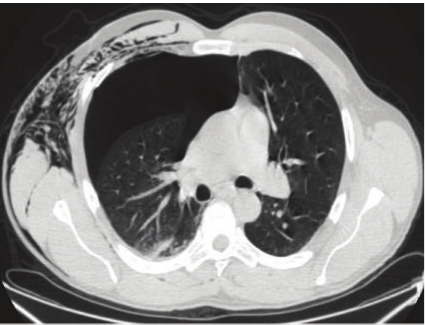
Figure 11: Tension pneumothorax. Axial MDCT in lung window at the level of the pulmonary trunk shows increased volume of the right hemithorax due to a large pneumothorax. This finding reduces the ipsilateral pulmonary volume and shifts the mediastinum to the left. A small contusion focus in the posterior segment of the right upper lobe and subcutaneous emphysema are also seen. This is an indication for immediate chest drainage.